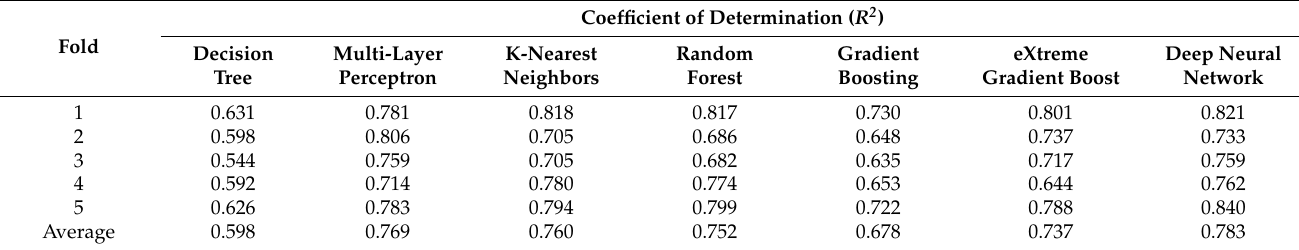
Table 6. K-fold cross validation results of seven machine learning models.